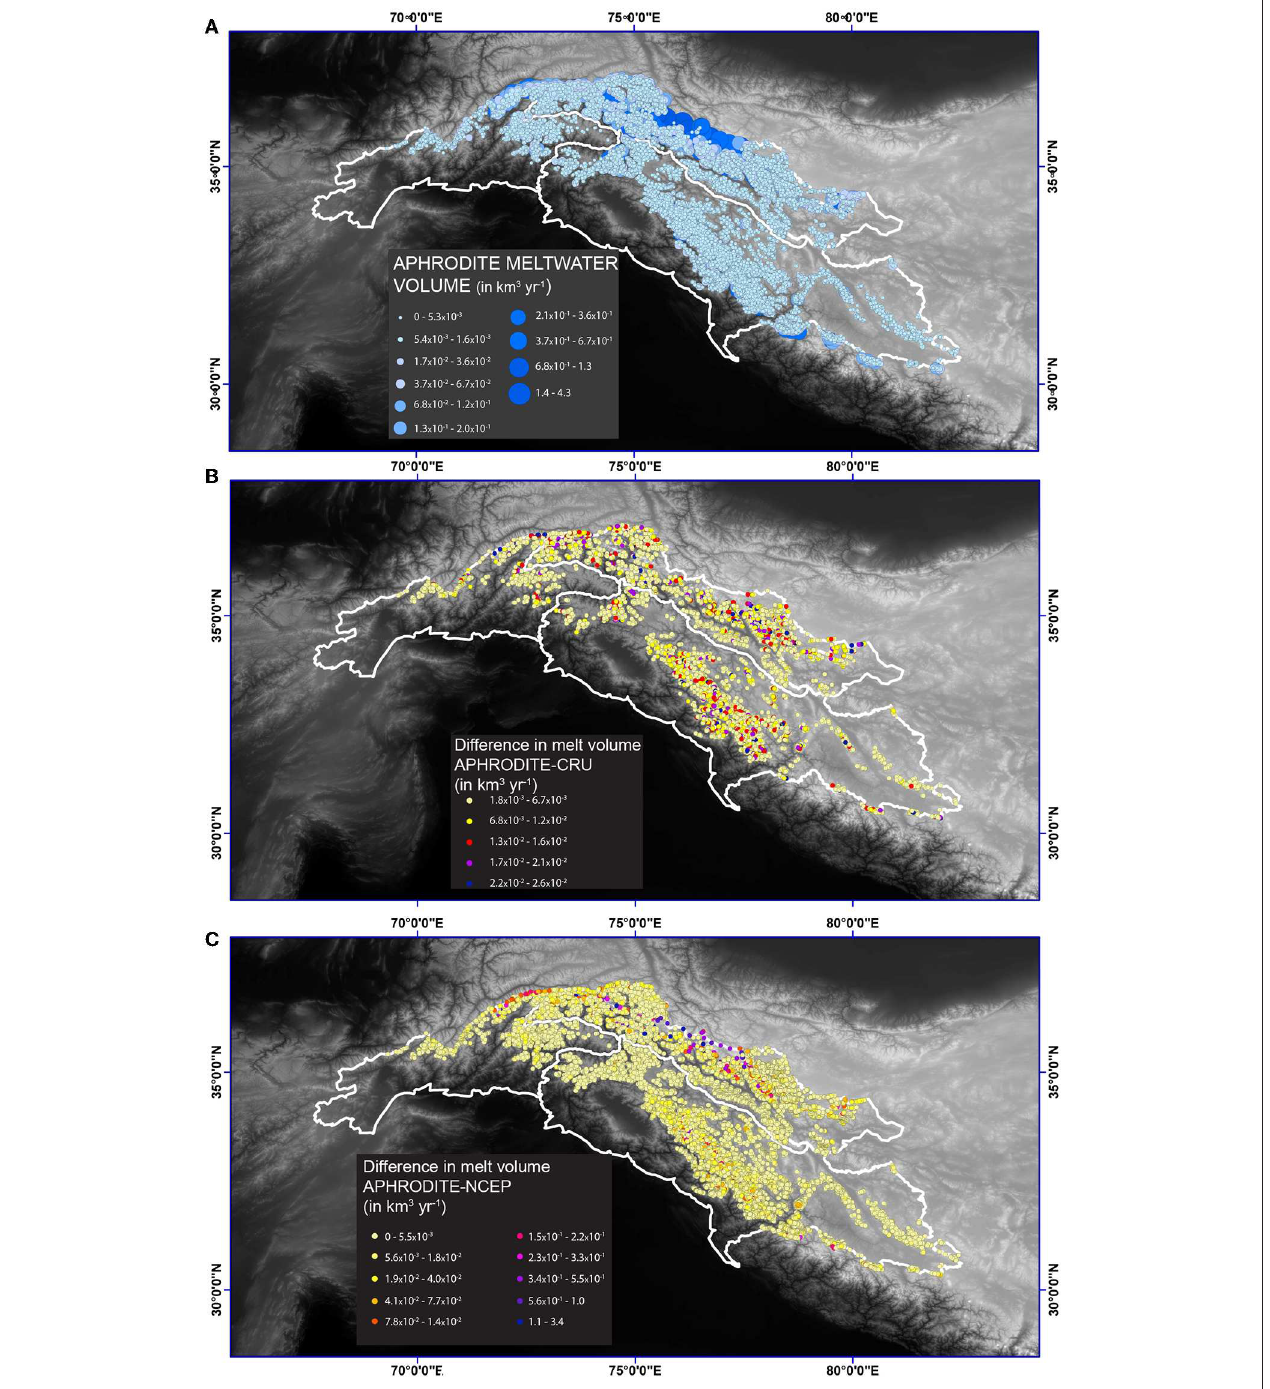
FIGURE 6 | (A) Distribution of mean annual meltwater flux by glacier across the Indus watershed. The meltwater fluxes were calculated using APHRODITE temperature dataset as control. (B) Difference in melt volume generated between APHRODITE and CRU temperature datasets. (C) Difference in melt volume generated between APHRODITE and NCEP datasets. Meltwater volumes are in km 3 /yr.